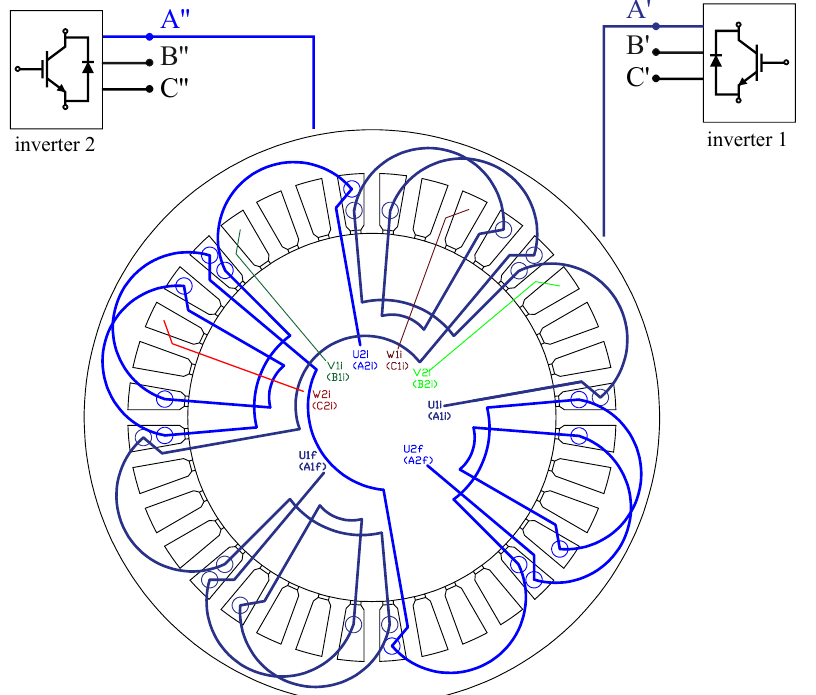
Figure 2. Supply condition schematic for phase A.